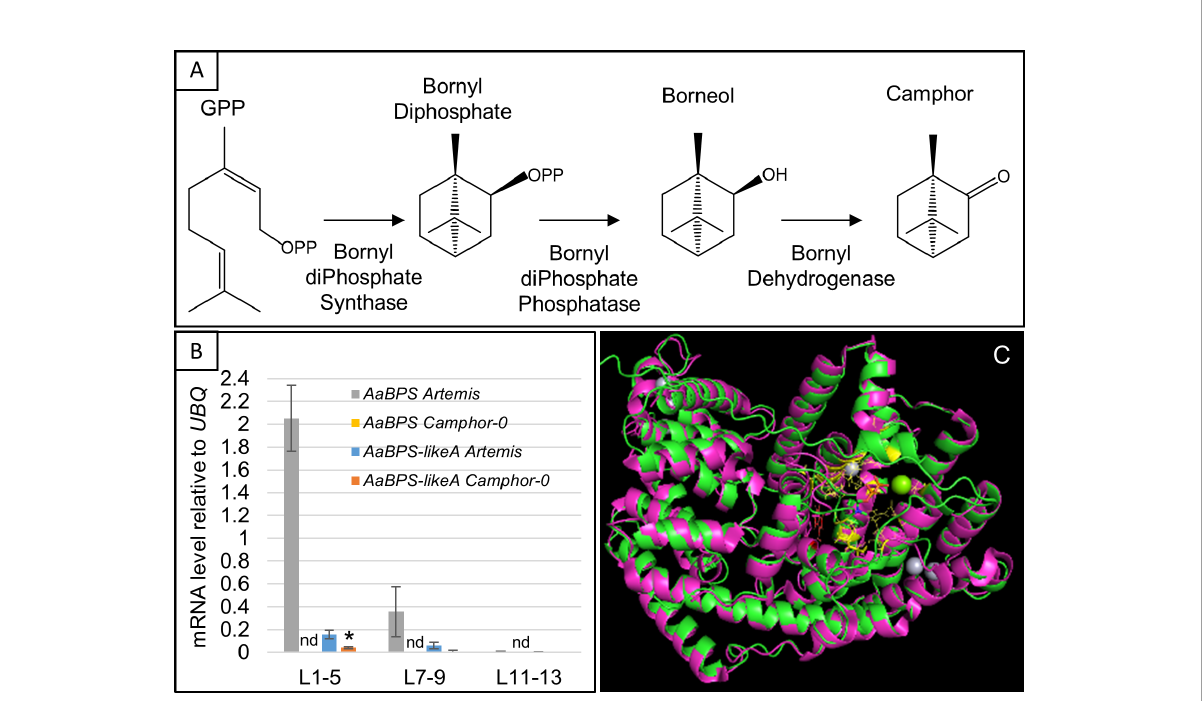
FIGURE 3 Identi fi cation of the AaBPS coding sequence and AaBPS expression. (A) Camphor biosynthesis pathway modi fi ed from (Croteau et al., 1981). (B) Expression of AaBPS and AaBPS-likeA in L1-5 juvenile, L7-9 expanding and L11-13 mature leaves. Error bars – SE (n=12). nd- transcript not detectable by qRT-PCR. * - statistically signi fi cant difference (t-test) between Artemis and camphor-0 at p<0.05. (C) Predicted AaBPS protein sequence was modelled (green) using the I-TASSER approach (C-score 0.5) and overlaid on sage (purple) Bornyl-diPhosphate Synthase